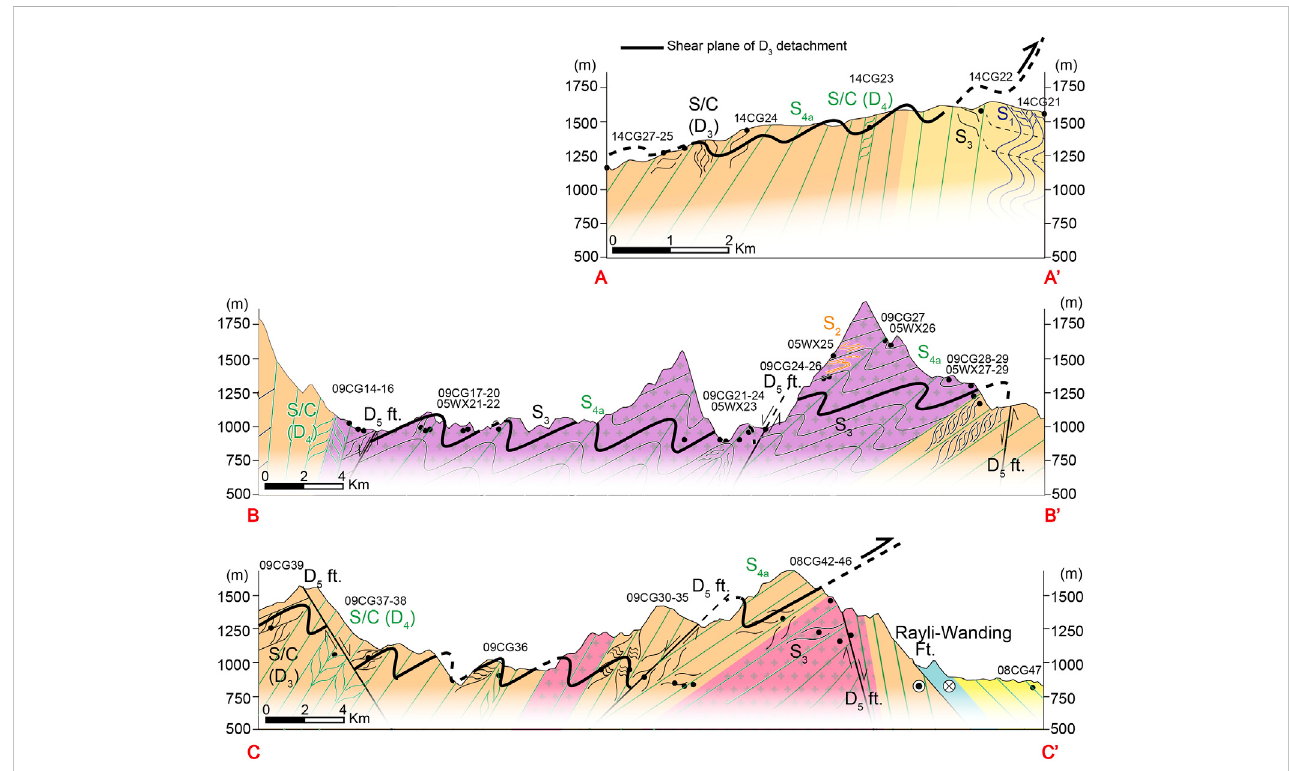
FIGURE 5 Reconstructed cross-sections of (A,A 9 ) , (B,B 9 ) , and (C,C 9 ) segments. The oldest D 1 fold formed the S 1 axial plane (blue lines). D 2 formed the sub- horizontal S 2 foliation and chemical layering (orange lines). D 3 thrust shear folding formed the S 3 fold axial plane (black). The thick black line marks the shear plane of theD 3 fold-thrust belt. The D 4 shear fabrics (green)deformedmultiple rock units, and theearly stage ofD 4 (D 4a )folded D 3 thrustshear belts, forming the S 4a axial plane (green) and then transformed into brittle deformation (D 4b ). The latest normal fault (thick gray line), D 5 , truncated all ductile